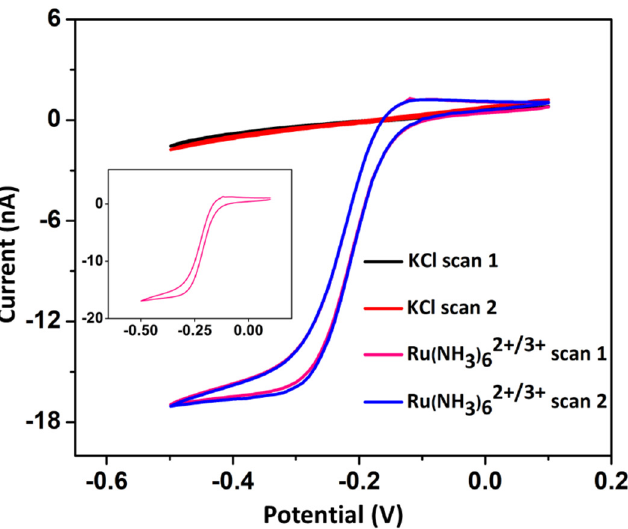
Figure 5. Electrochemical characterization of CNTs bonded to metal surfaces. Cyclic voltammograms of CNTs bonded to Cu as the working electrode: red and black lines = background response in 0.5 M KCl aqueous solution; pink and blue lines (pink barely visible under the blue) = response for 2 mM Ru(NH 3 ) 6 2+/3+ in 0.5 M aqueous KCl solution. The pink line corresponding to 2 mM Ru(NH 3 ) 6 2+/3+ in 0.5 M aqueous KCl has been replotted as an inset to make it visible.